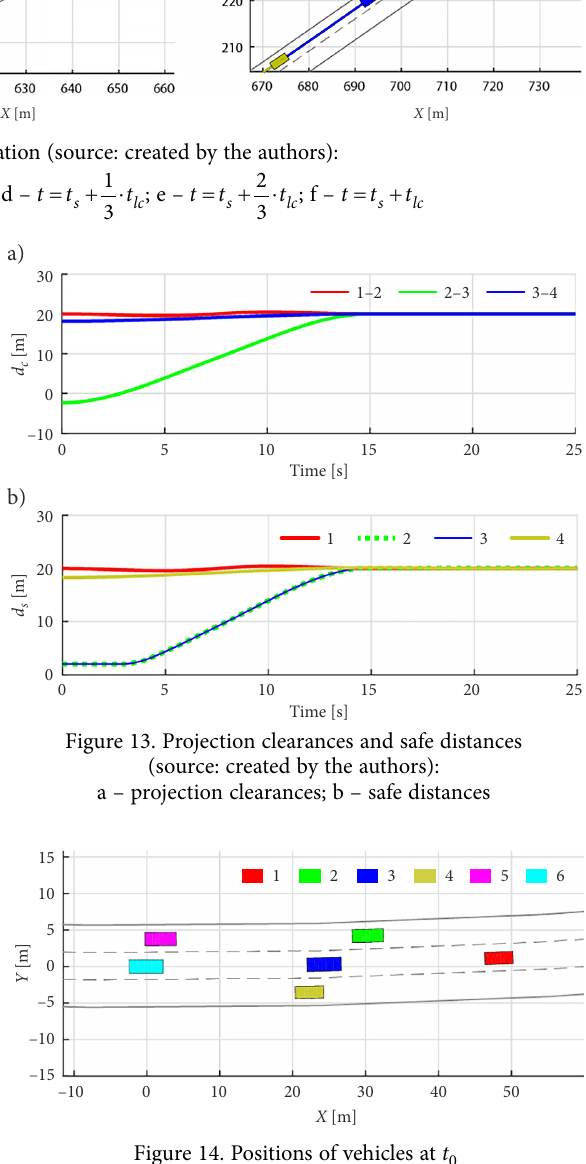
Figure 14. Positions of vehicles at t 0 (source: created by the